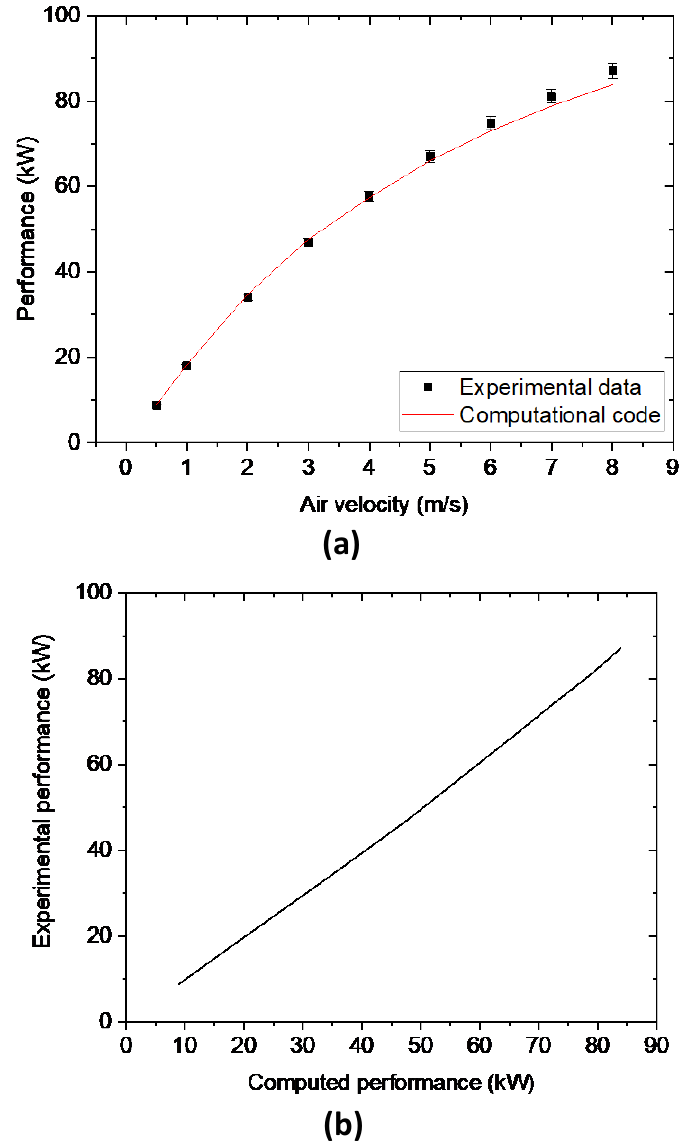
Figure 10. Variation versus airflow velocities of ( a ) exchanger’s performance obtained experimentally and using the computational code and ( b ) relative error of the computational code.